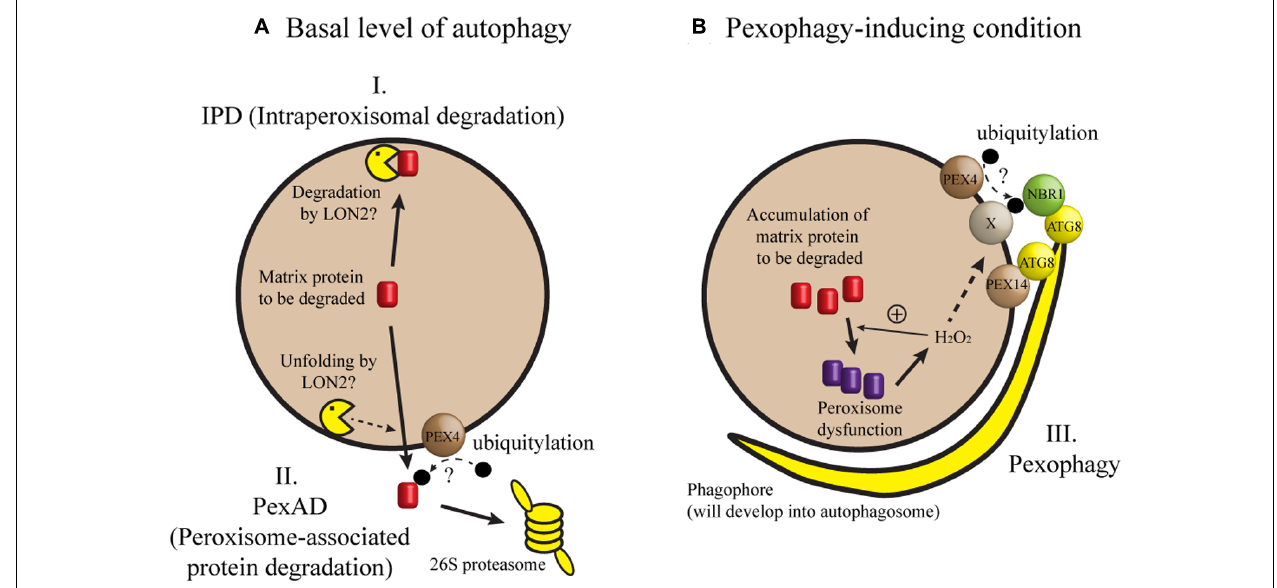
FIGURE 1 | A model of peroxisomal protein degradation in plant cells. (A) When autophagy occurs at a basal level or when a core ATG gene is missing, degradation of matrix proteins like ICL and MLS may depend on intraperoxisomal degradation (IPD) or peroxisome-associated protein degradation (PexAD). (B) Pexophagy may be induced by loss of LON2 , inactivation of IPD and PexAD, or a developmental process in which peroxisomes are past a critical level of oxidative stress (for example, intensive fatty acid β -oxidation during early seedling growth).